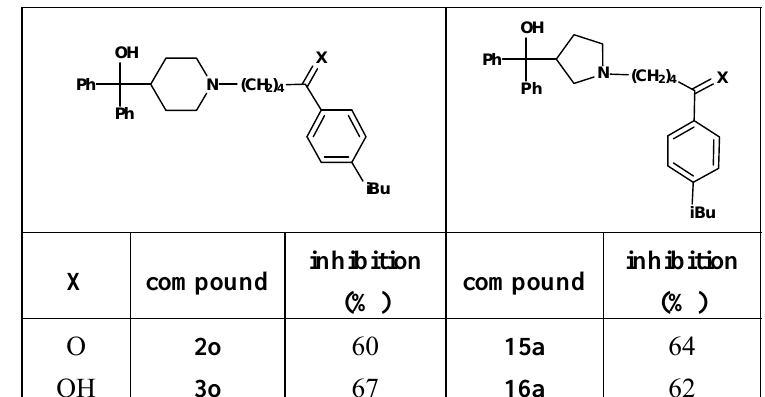
Table 8. Inhibition of protein interaction in AN assay by compounds 15a , 16a compared to compounds 2p and 3p (R = azacyclonol, concentration: 50 µM, standard deviation ≤ 6